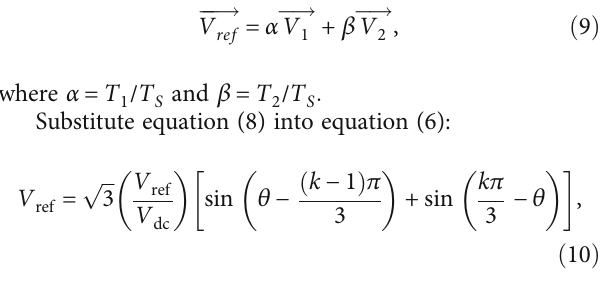
V V an , bn , and cn ) and spectrum of